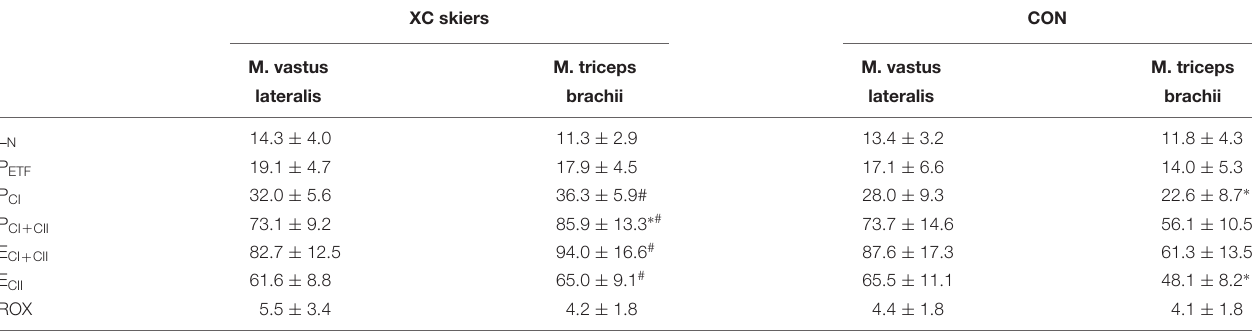
TABLE 2 | Mitochondrial respiratory flux in M. vastus lateralis and M. triceps brachii of the elite cross-country (XC) skiers and the physically active control (CON) group of this study (means ±